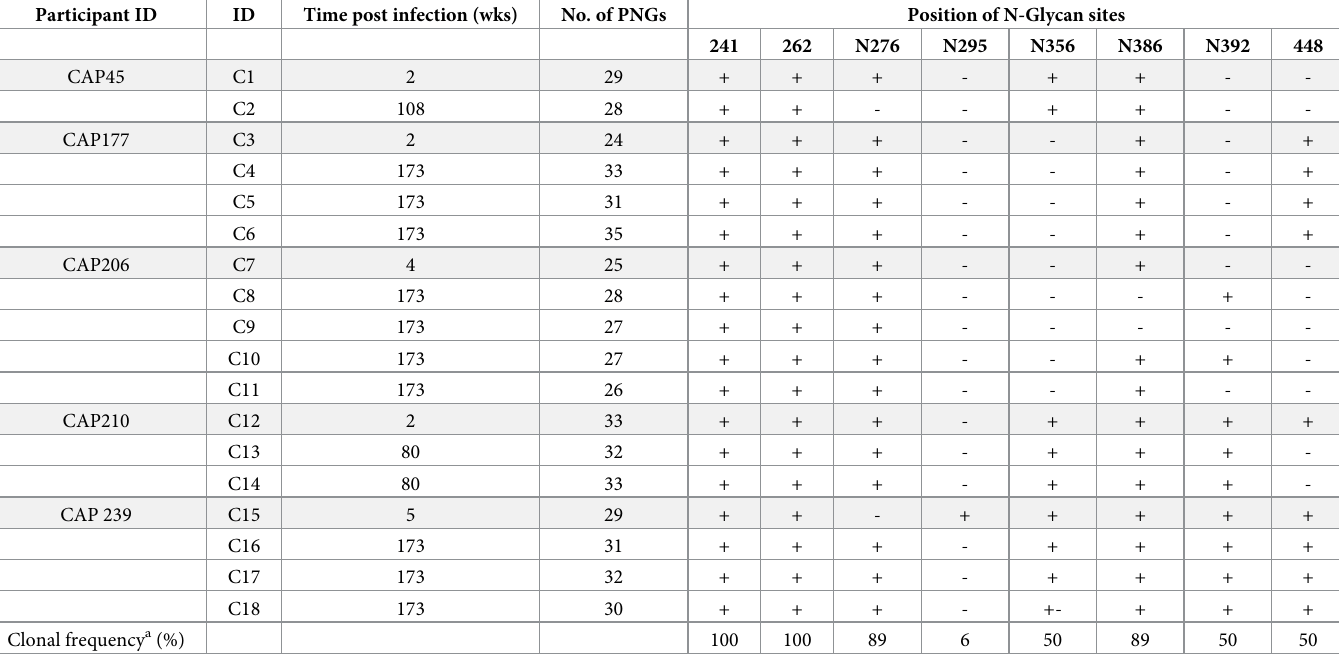
Table 1. Characterisation of Envelope clones and conservation of potential N-glycan sites (PNGs). Participant ID ID CAP45